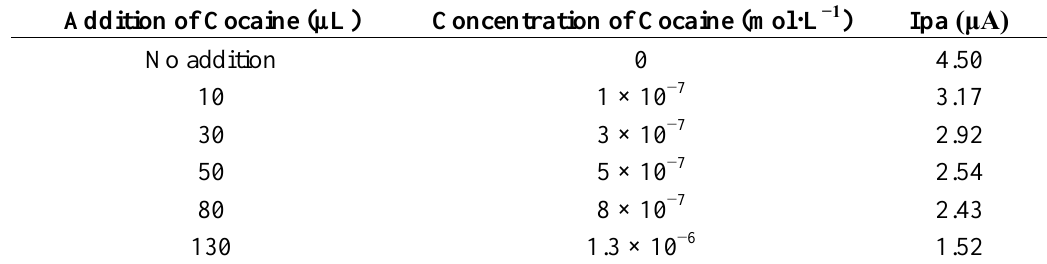
Table 2. Voltammetric parameters obtained with successive addition of standard